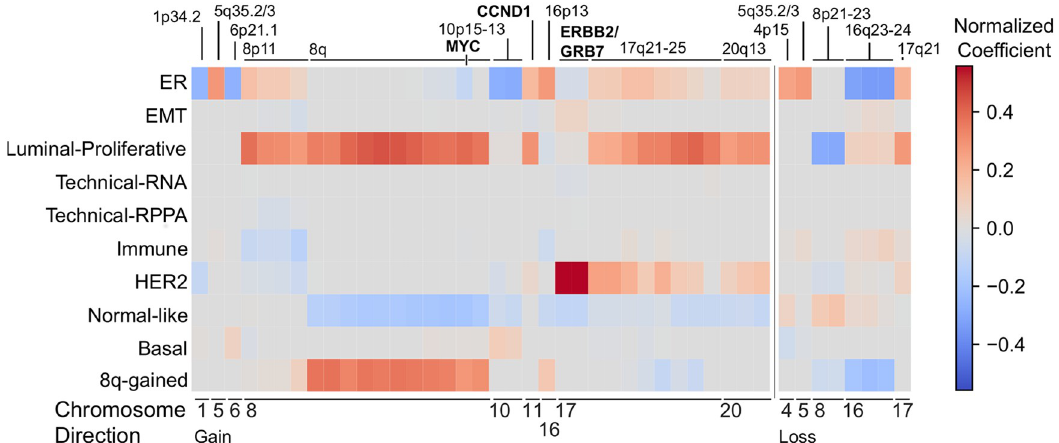
Fig 4. Copy number and factors in the TCGA breast cancer dataset. Normalized coefficients representing the contribution of DNA copy number aberrations to the factors. Specifically, the coefficients represent the contribution of recurrently gained (left) or lost (right) copy number regions identified by RUBIC to the factors represented in the rows. Recurrently aberrated copy number regions are annotated with chromosomal bands or putative driver genes in the region.